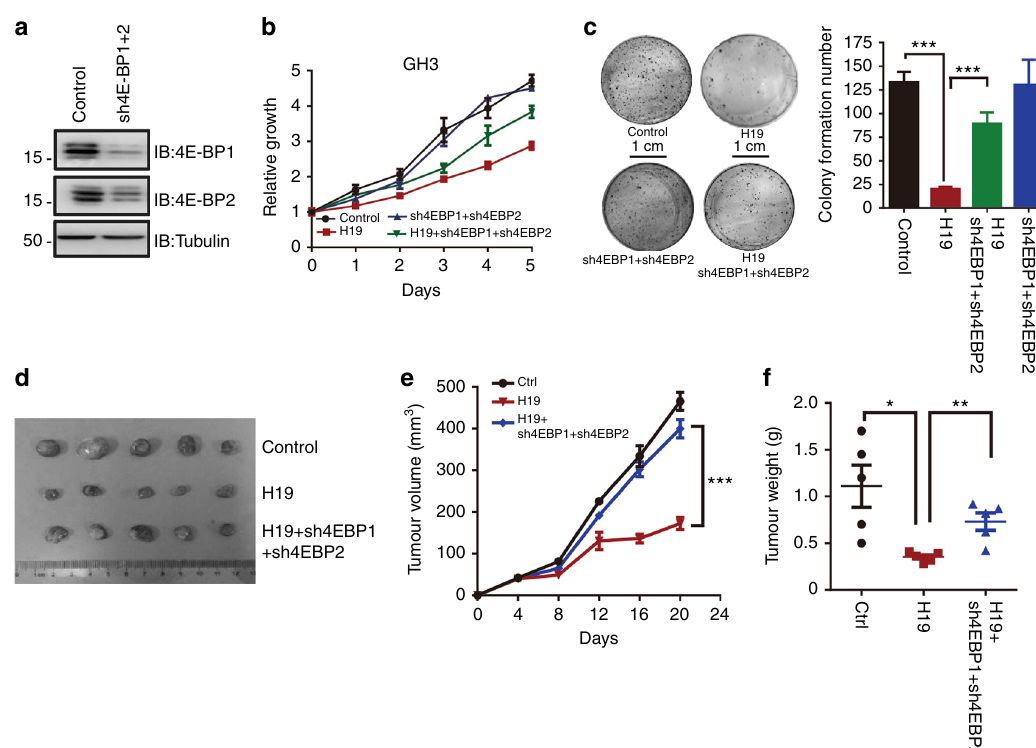
Fig. 4 H19 suppresses pituitary tumour proliferation by mTORC1 – 4E-BP1 axis. a GH3 cells were simultaneously infected with lentiviral 4E-BP1 shRNA and 4E-BP2 shRNA or a control shRNA. 4E-BP1 and 4E-BP2 protein levels were monitored by western blot. b 4E-BP1 and 4E-BP2 double knockdown rescues H19-mediated GH3 cell growth suppression. Cell viability was detected periodically for 5 days using MTS assays and is expressed as relative proliferation (fold change over value on day 1). Error bars represent the SDs in triplicate. c A colony formation assay shows that 4E-BP1 and 4E-BP2 double knockdown rescues H19-mediated GH3 cell growth suppression. Cells were seeded into six-well plates with 200 cells per well and cultured for 10 days, followed by crystal violet staining and colony counting (scale bar, 1 cm, *** p < 0.001; n = 3). d 4E-BP1 and 4E-BP2 double knockdown rescues the growth of H19- overexpressing GH3 xenograft tumours. After mice bearing tumours were sacri fi ced, the tumour tissues were collected, photographed ( d ) and weighed ( f ). e The growth of GH3 xenograft tumours was measured by tumour volume. Tumour size was monitored every four days. The data ( n = 5) were analysed using a sample-paired Student ’ s t- test; *** p < 0.001. f Tumour weight was measured in each group at the end of the experiment. Error bars are the mean ± SEM values. * p < 0.05, and ** p <